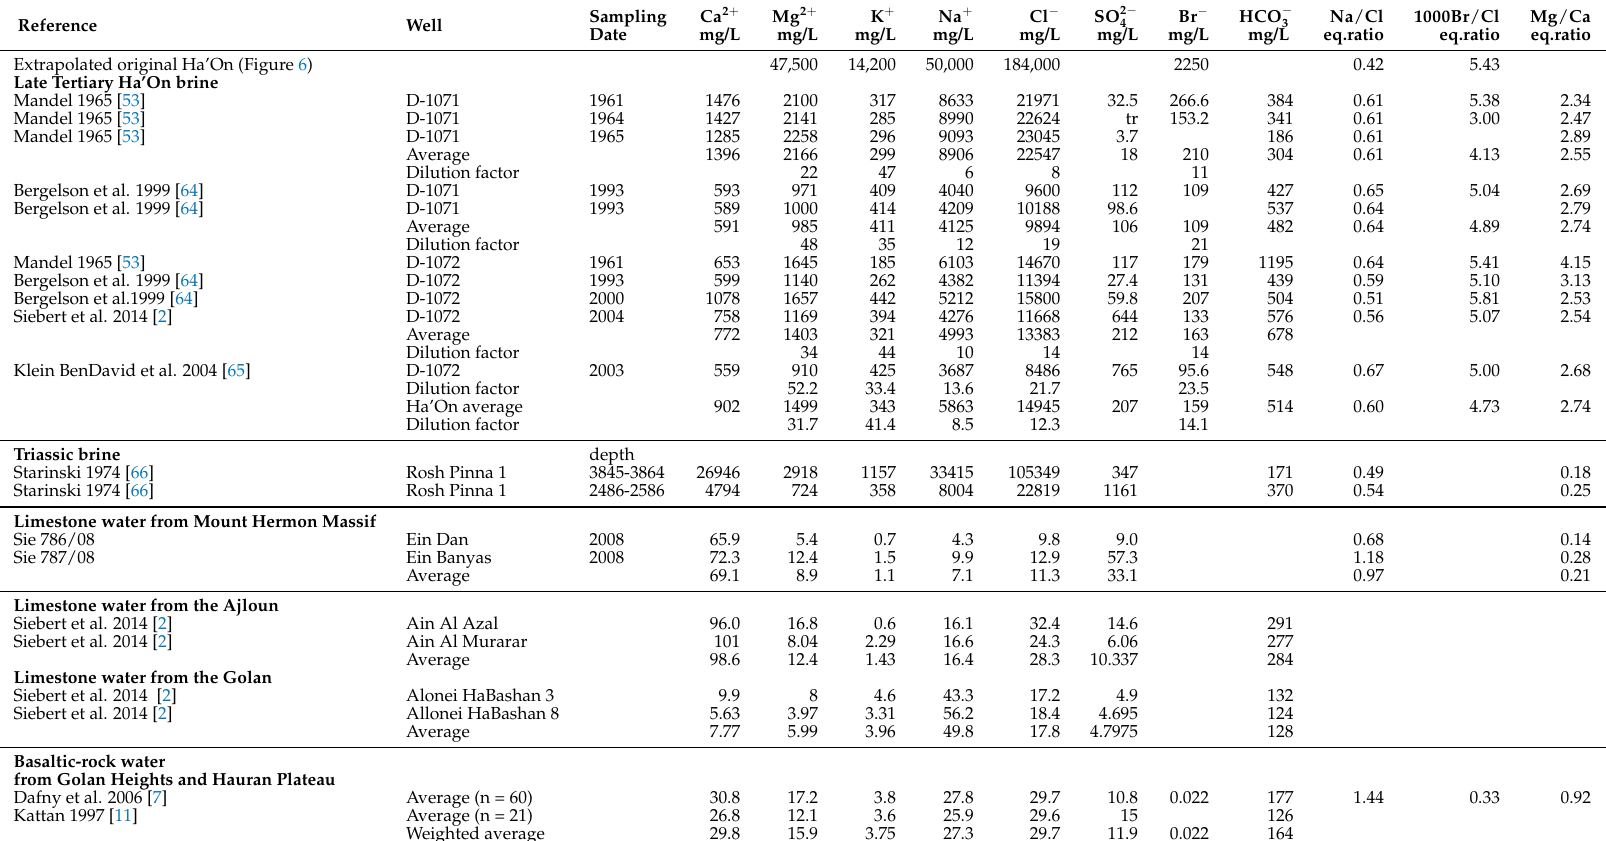
Table A1. Analyses of Ha’On brine, Triassic brines of Rosh Pinna, basaltic spring waters from the Golan Heights and the Hauran Plateau and limestone waters from the Ajloun Mountains and Golan Heights. Because the analyses of Ha’On brine are from different wells for each group, the average and standard deviation (%) are given. The extrapolated concentrations of Mg 2 + , K + , Na + , Cl − and Br − of the original Ha’On are derived from data on evaporated seawater